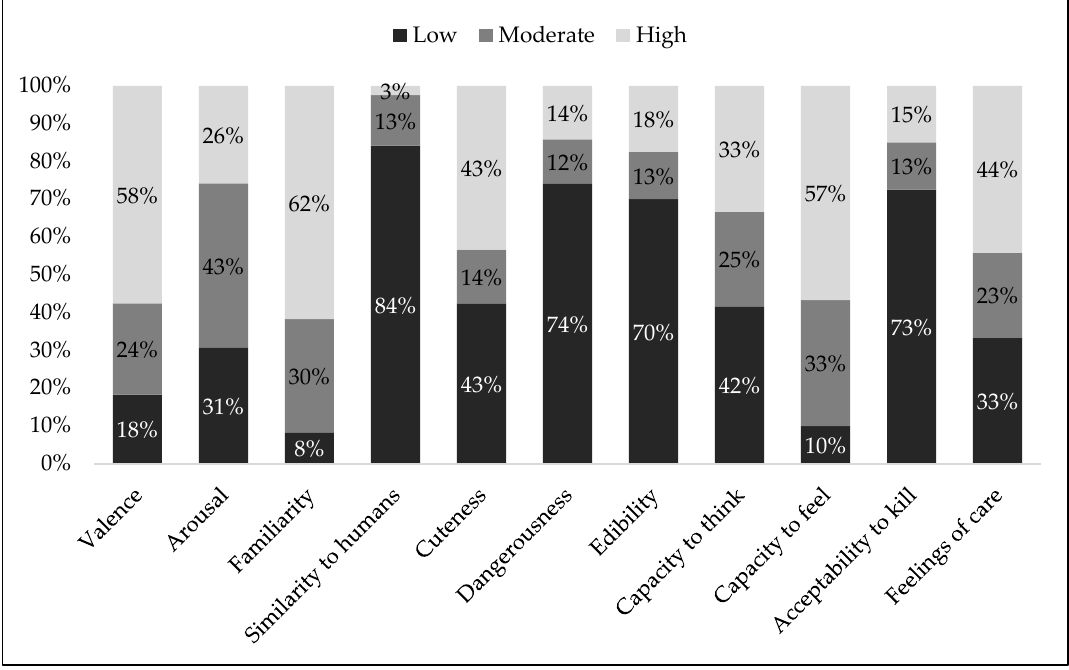
Figure 2. Distribution of animal images with low, medium and high rating on each evaluative Figure2. Distributionofanimalimageswithlow, dimension.